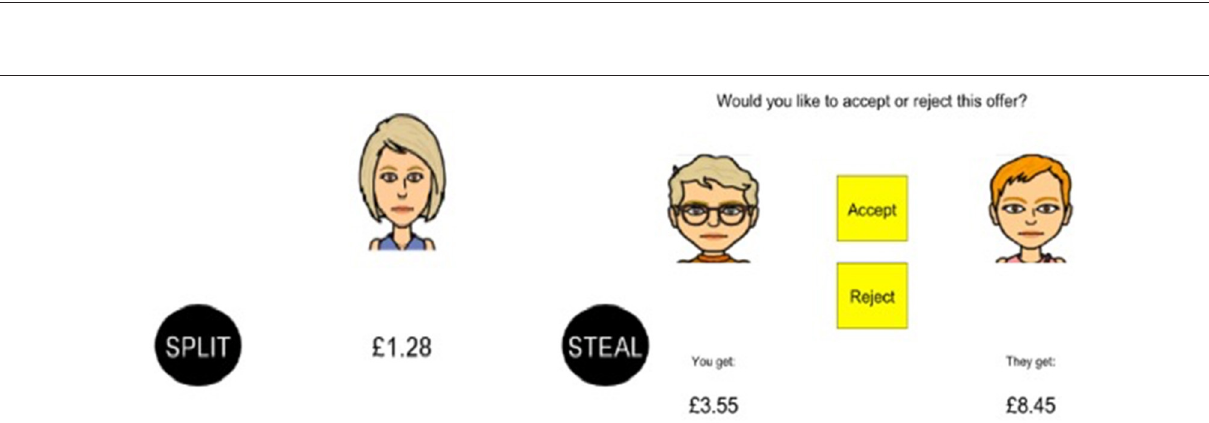
Frontiers in Psychiatry | www.frontiersin.org